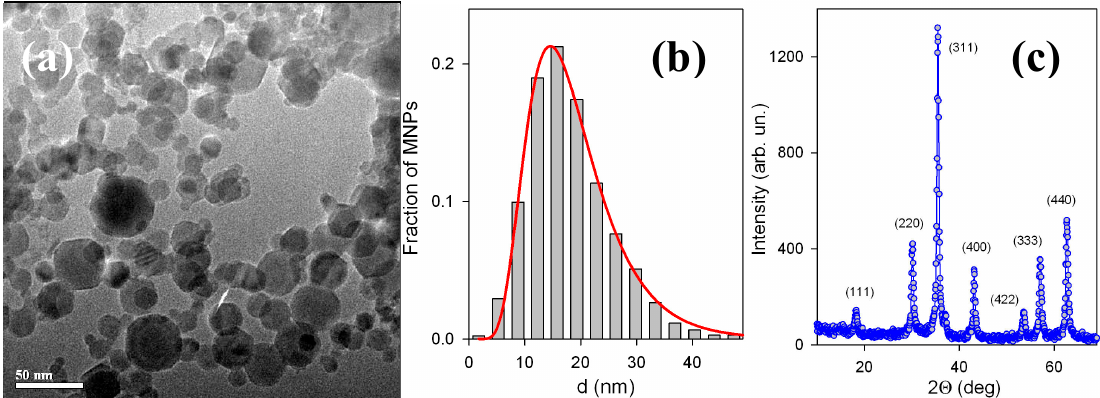
Figure 3. TEM image of iron oxide MNPs embedded in ferrogels ( a ). Particle size distribution obtained by the graphical analysis of 2160 particles ( b ); Inset ( c ) XRD pattern for MNPs with corresponding Miller indexes.